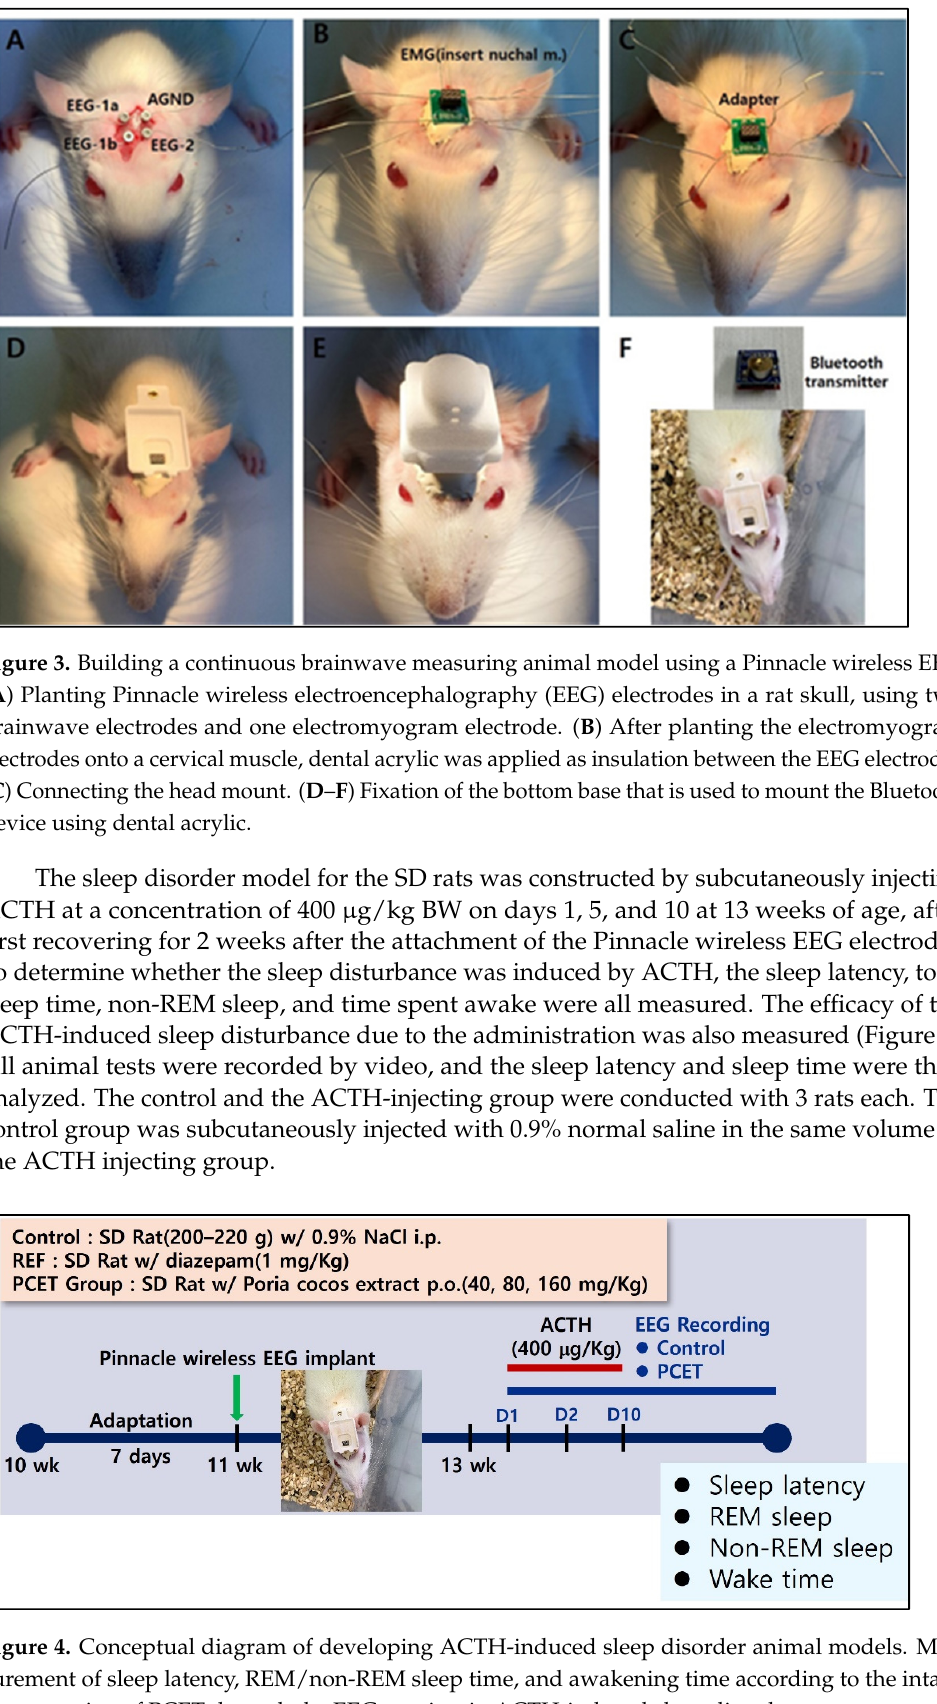
Figure 4. Conceptual diagram of developing ACTH-induced sleep disorder animal models. Meas- urement of sleep latency, REM/non-REM sleep time, and awakening time according to the intake concentration of PCET through the EEG monitor in ACTH-induced sleep disorder rats.